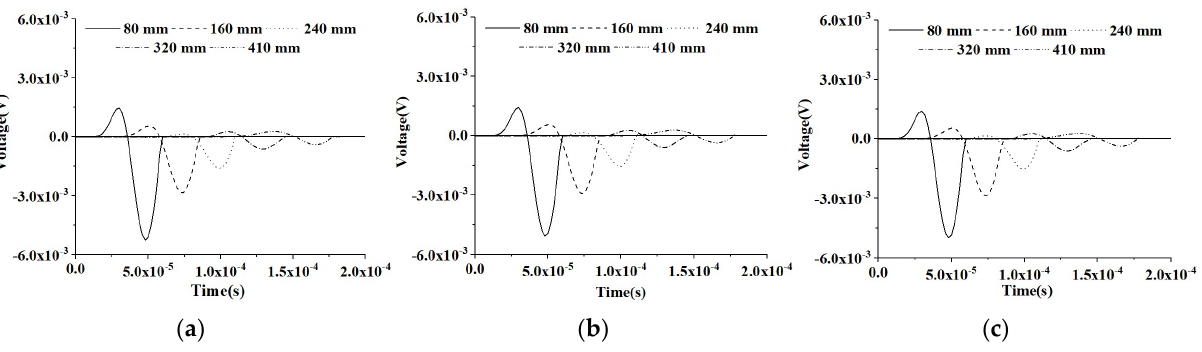
Figure 11. Response of PZT sensors at different measurement distances from the actuator under modulated sinusoidal excitation of CHFEMs with an interface debond corresponding to CMFEM 1 using different RAE dimensions: ( a ) 20 mm; ( b ) 25 mm; ( c ) 40 mm.